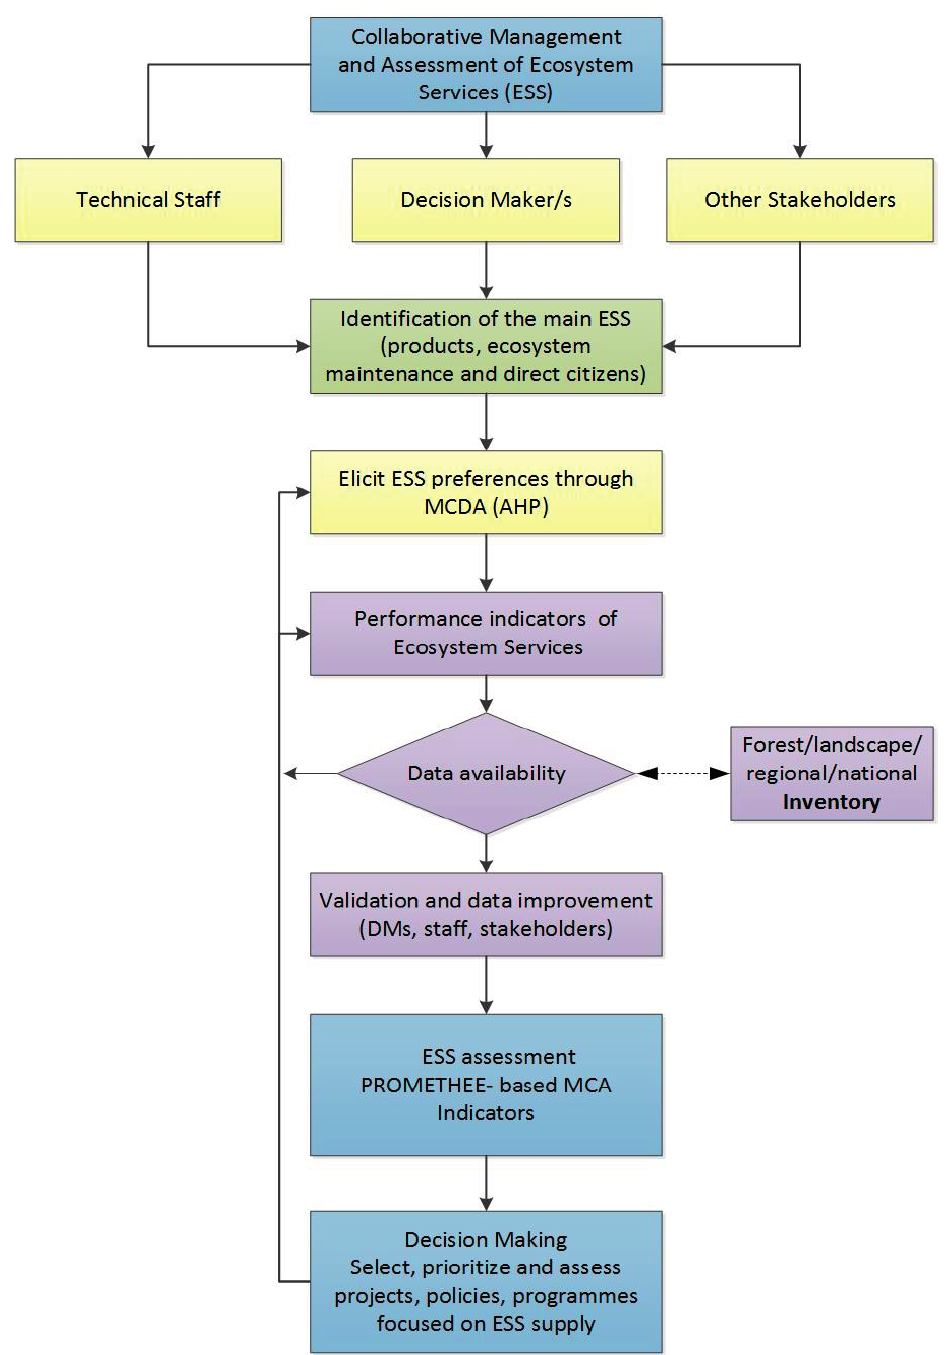
Figure 1. Methodology for implementing collaborative management and assessment ecosystem